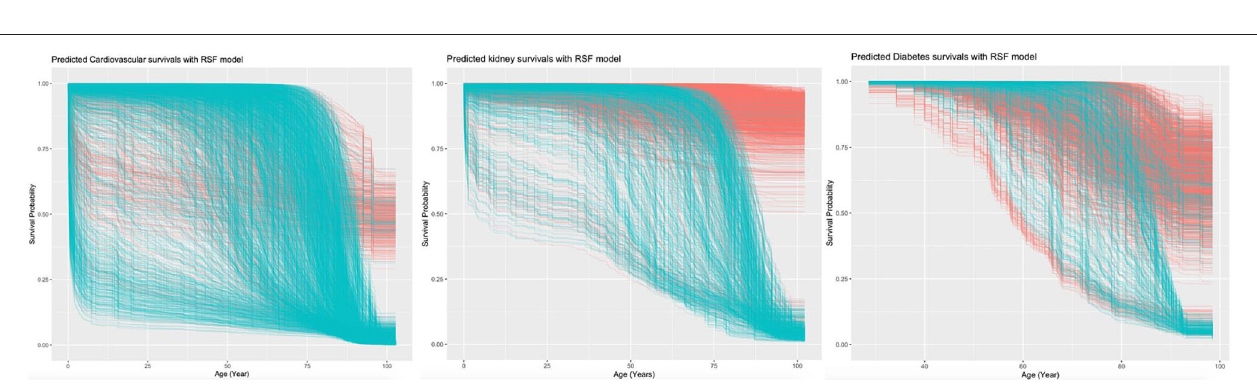
FIGURE 2 | Kaplan-Meier curves for all-cause mortality and the predicted mortality. The Kaplan-Meier survival curves demonstrate the moralities of the patients with pulmonary hypertension (PHTN) (A) and the predicted mortalities using the random survival forest (RSF) prediction (B) . Each line represents a single patient in the training data set, where censored patients are colored blue, and patients who have experienced the mortality event are colored in red. The median survival (black) with a 95% shaded confidence band (gray) are indicated.